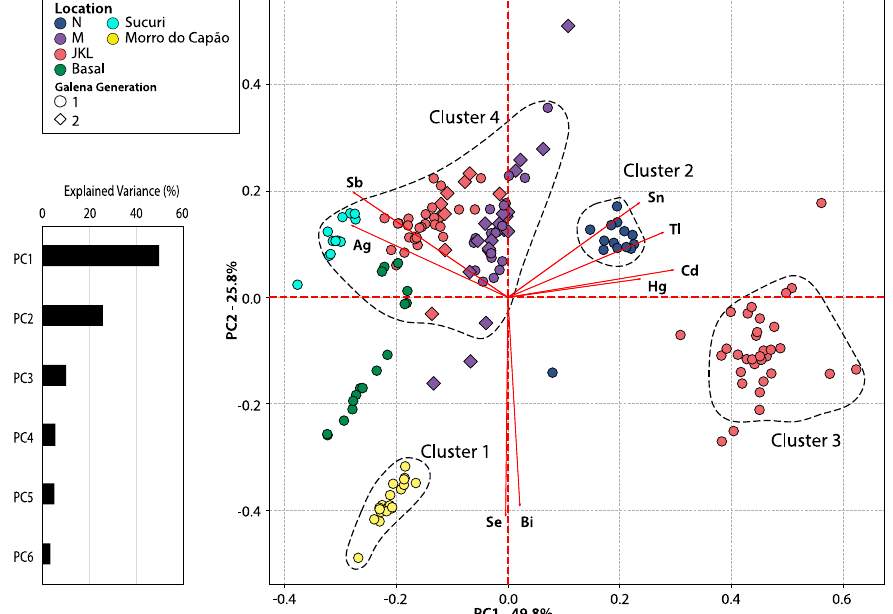
Figure 15. Biplot of PC1 (49.8%) and PC2 (25.8%) of the galena mineral chemistry from the Morro Agudo district with associated eigenvalues (explained variance).